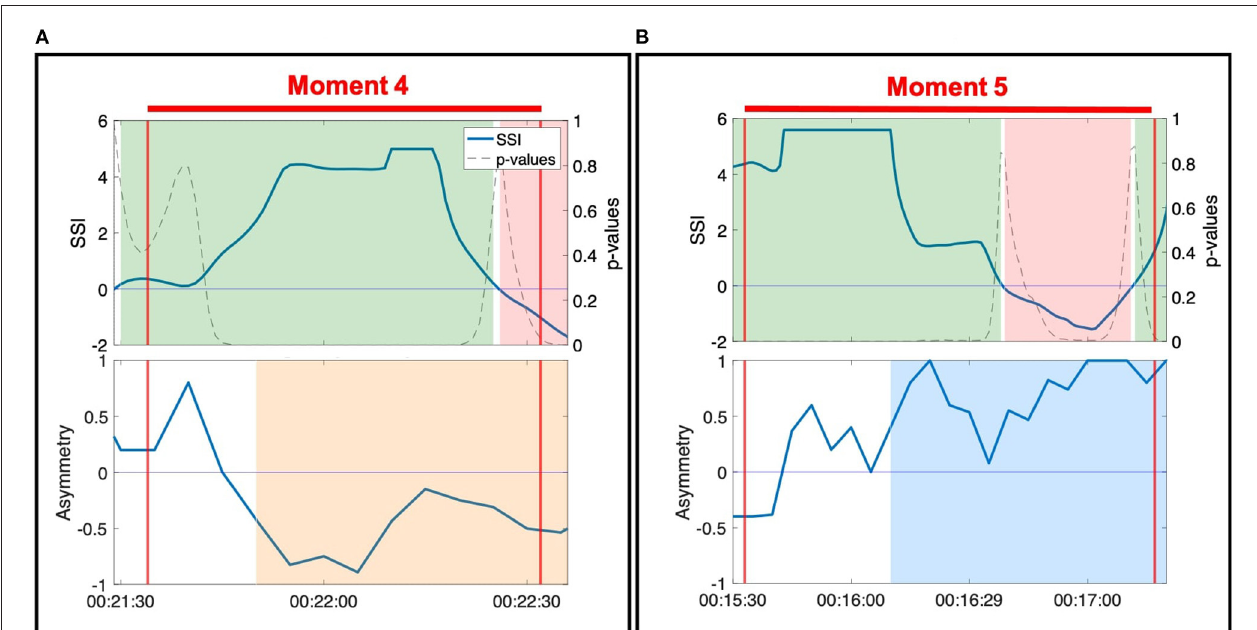
FIGURE 4 | SSI and NSTE asymmetry values during two moments of connection: (A) Moment 4: Anne and Erica during the resistance standing activity. (B) Moment 5: Ruth and Harvey during the resistance sitting activity.